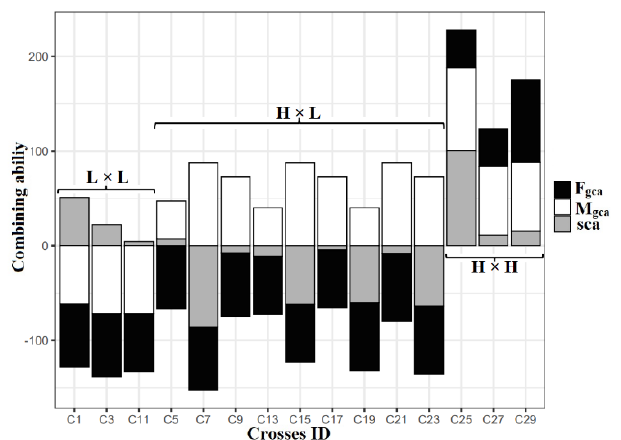
Figure 4. Comparison of the relationship between parental GCA and F 1 ’s SCA on the number of filled grains per panicle for 15 direct crosses. F gca , GCA effect of the female parent; M gca , GCA effect of the male parent; SCA, SCA effect of F 1 s; L, low GCA; H, high GCA. Phenotypic comparison of IET 28749 × IET 28834 (high × low mean) hybrid and its parents showed that F 1 had the intermediate mean value between the two parents for the number of filled grains per panicle, number of primary branches, and number of secondary branches (Figure 5).